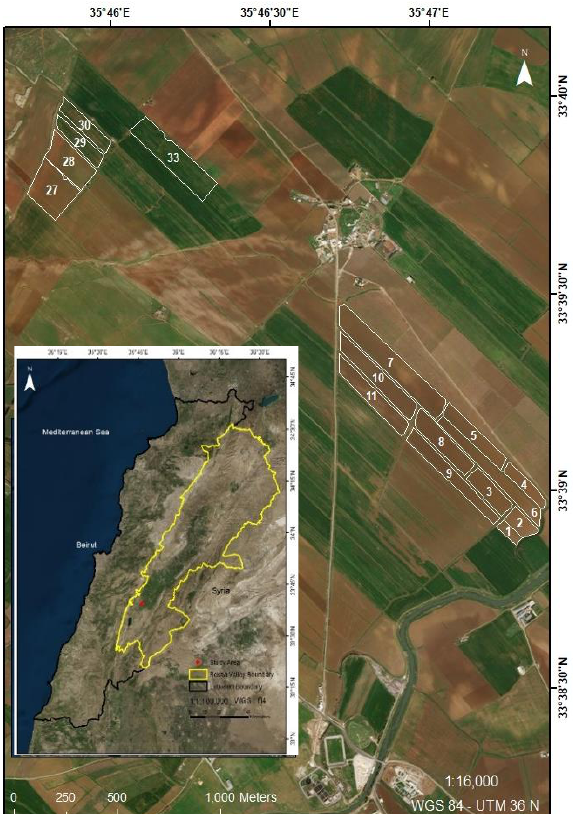
Figure 2. Lebanon study area field locations in the Bekaa Valley, Lebanon. (WGS 84 - UTM